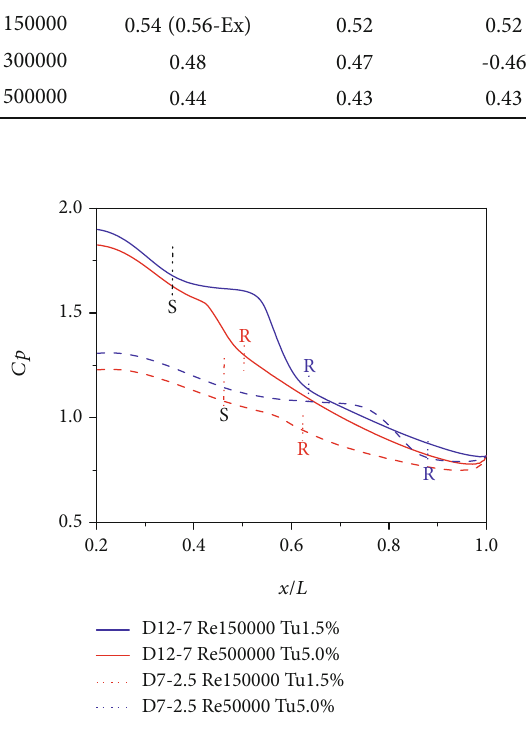
ff erent opening